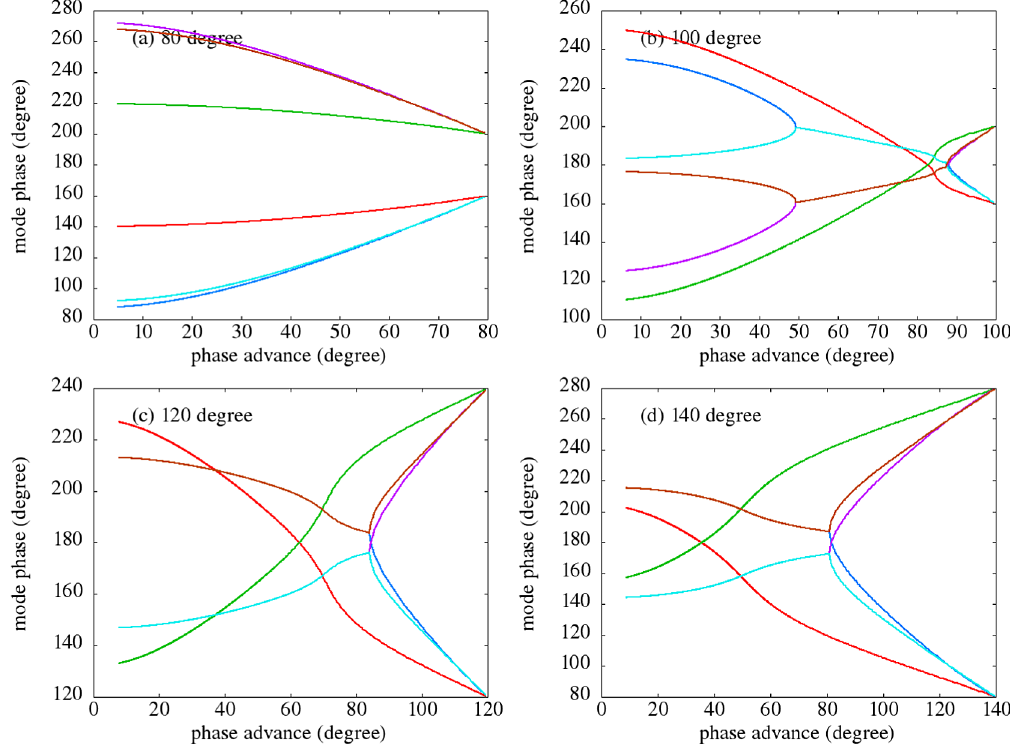
FIG. 9. The 3D envelope mode phases as a function of depressed transverse phase advance with (a) 80 °, (b) 100 °, (c) 120 °, and (d) 140 ° zero current longitudinal and transverse phase advances in a periodic quadrupole-rf channel. The six colors are the phases of the six